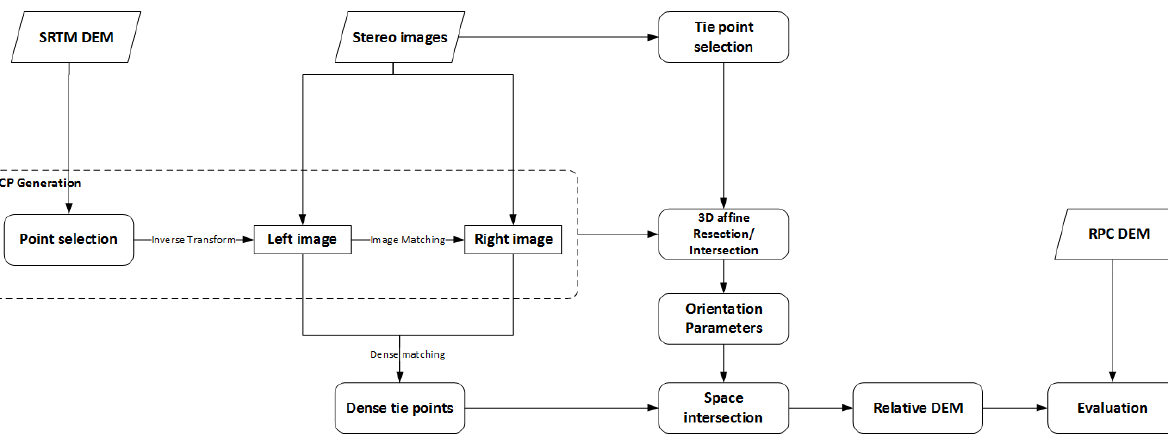
Figure1. Flow-diagram of the proposed